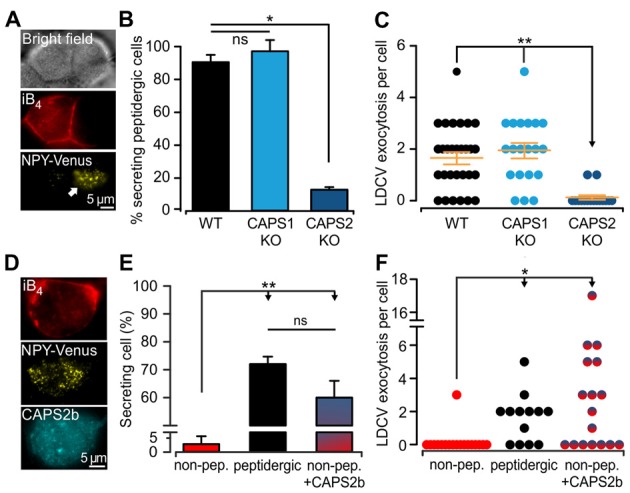
CAPS2 is the priming factor of LDCVs in DRG neurons. (A) Exemplary images of CAPS1 KO DRG neurons. The two cells visible in the bright field image (top) are either non-peptidergic (stained red with iB4-Alexa561, middle left) or peptidergic (middle right). LDCV exocytosis was measured in the NPY-Venus transfected peptidergic neuron (white arrow, total internal reflection fluorescence microscopy image, bottom). The stimulation protocol was the same as that in Figure 2. (B) Percentage of peptidergic neurons that secreted LDCVs depending on their genotype; which were WT, CAPS1 KO and CAPS2-deficient (CAPS2 KO). The number of preparations (i.e., mice) was 7, 7, and 4 for WT, CAPS1 KO and CAPS2 KO, respectively (ANOVA on ranks Holm-Sidak method: *p < 0.05). (C) Scatter dot plots of total LDCV exocytosis in the CAPS1 KO and CAPS2 KO peptidergic neurons in comparison to their respective WT controls. Orange dashes are the average LDCV exocytosis ± SEM (Nmice = 7, 7, and 4, nneurons = 32, 20 and 16 for WT, CAPS1 KO, and CAPS2 KO, respectively; ANOVA on ranks Kruskal-Wallis test: **p < 0.01). (D) Representative image of a WT non-peptidergic DRG neuron co-transfected with NPY-Venus and CAPS2-mTFP. The neuron was identified by triple staining in red for iB4-Alexa568 (top), yellow for NPY-Venus (middle), and cyan for CAPS2-mTFP (bottom). LDCV exocytosis induced by the protocol illustrated in Figure 2 was assessed in these neurons and compared to exocytosis in WT peptidergic and non-peptidergic neurons transfected with NPY-Venus only. (E) Proportion of secreting WT neurons that were non-peptidergic, peptidergic and non-peptidergic transfected with CAPS2. Note that ectopic expression of CAPS2 in non-peptidergic neurons converts these neurons to LDCV secreting cells. (F) Scatter dot plots of total LDCV secretion from WT neurons that were non-peptidergic, peptidergic and non-peptidergic overexpressing CAPS2. For panels (E,F) Nmice = 13, nneurons = 34, 13, 17 for non-peptidergic, peptidergic and non-peptidergic overexpressing CAPS2, respectively. **p < 0.01, *p < 0.05 and ns (not significant) p > 0.05, one-way ANOVA Dunn’s test.